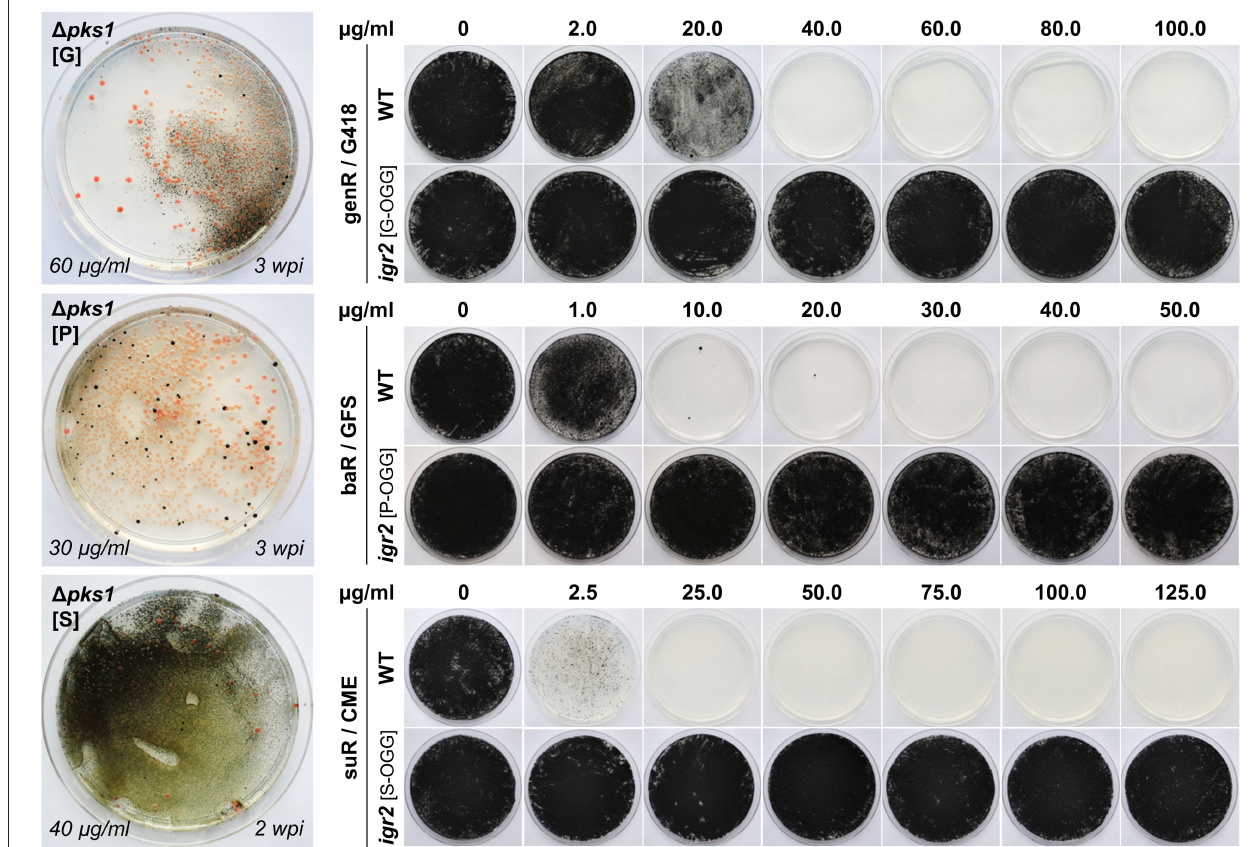
FIGURE 3 | Implementation of genR, baR and suR selection marker systems in K. petricola . Pink 1 pks1 mutants were generated by co-transformation of WT:A95 protoplasts with pAMA/ribo- pks1 PS2 and 1 pks1 fragments containing genR (G), baR (P), and suR (S) cassettes ( Supplementary Table 4 ). Pictures of transformation plates with pink colonies and black background growth after 2–3 weeks of incubation are shown on the left. DNA uptake and homologous integration were tested for six pink mutants per selection marker by diagnostic PCR ( Supplementary Figure 7 ). Black strains igr2 (G/P/S-OGG) containing a GFP expression cassette fused to a genR, baR or suR cassette were generated by co-transformation of WT:A95 protoplasts with pAMA/ribo- igr2 PS1 and expression constructs amplified with primers containing 5 ′ overhangs to igr2 . Targeted insertion was examined in six strains per construct ( Supplementary Figure 8 ). For evaluating the sensitivities of the wild type compared to those of the resistance gene-expressing strains, 5 × 10 5 cells were spread onto solidified SDNG supplemented with the indicated concentrations of the selective agents geneticin (G418), glufosinate ammonium (GFS) or chlorimuron ethyl (CME) and incubated for 3 weeks in darkness at 25 ◦ C.